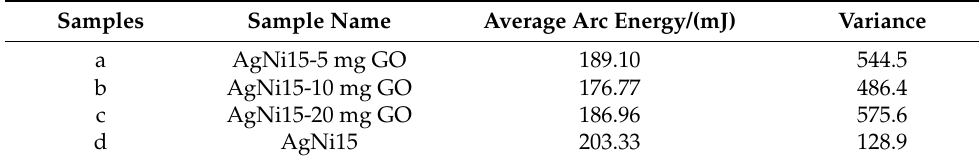
Table 3. Average arc energy and variance of the